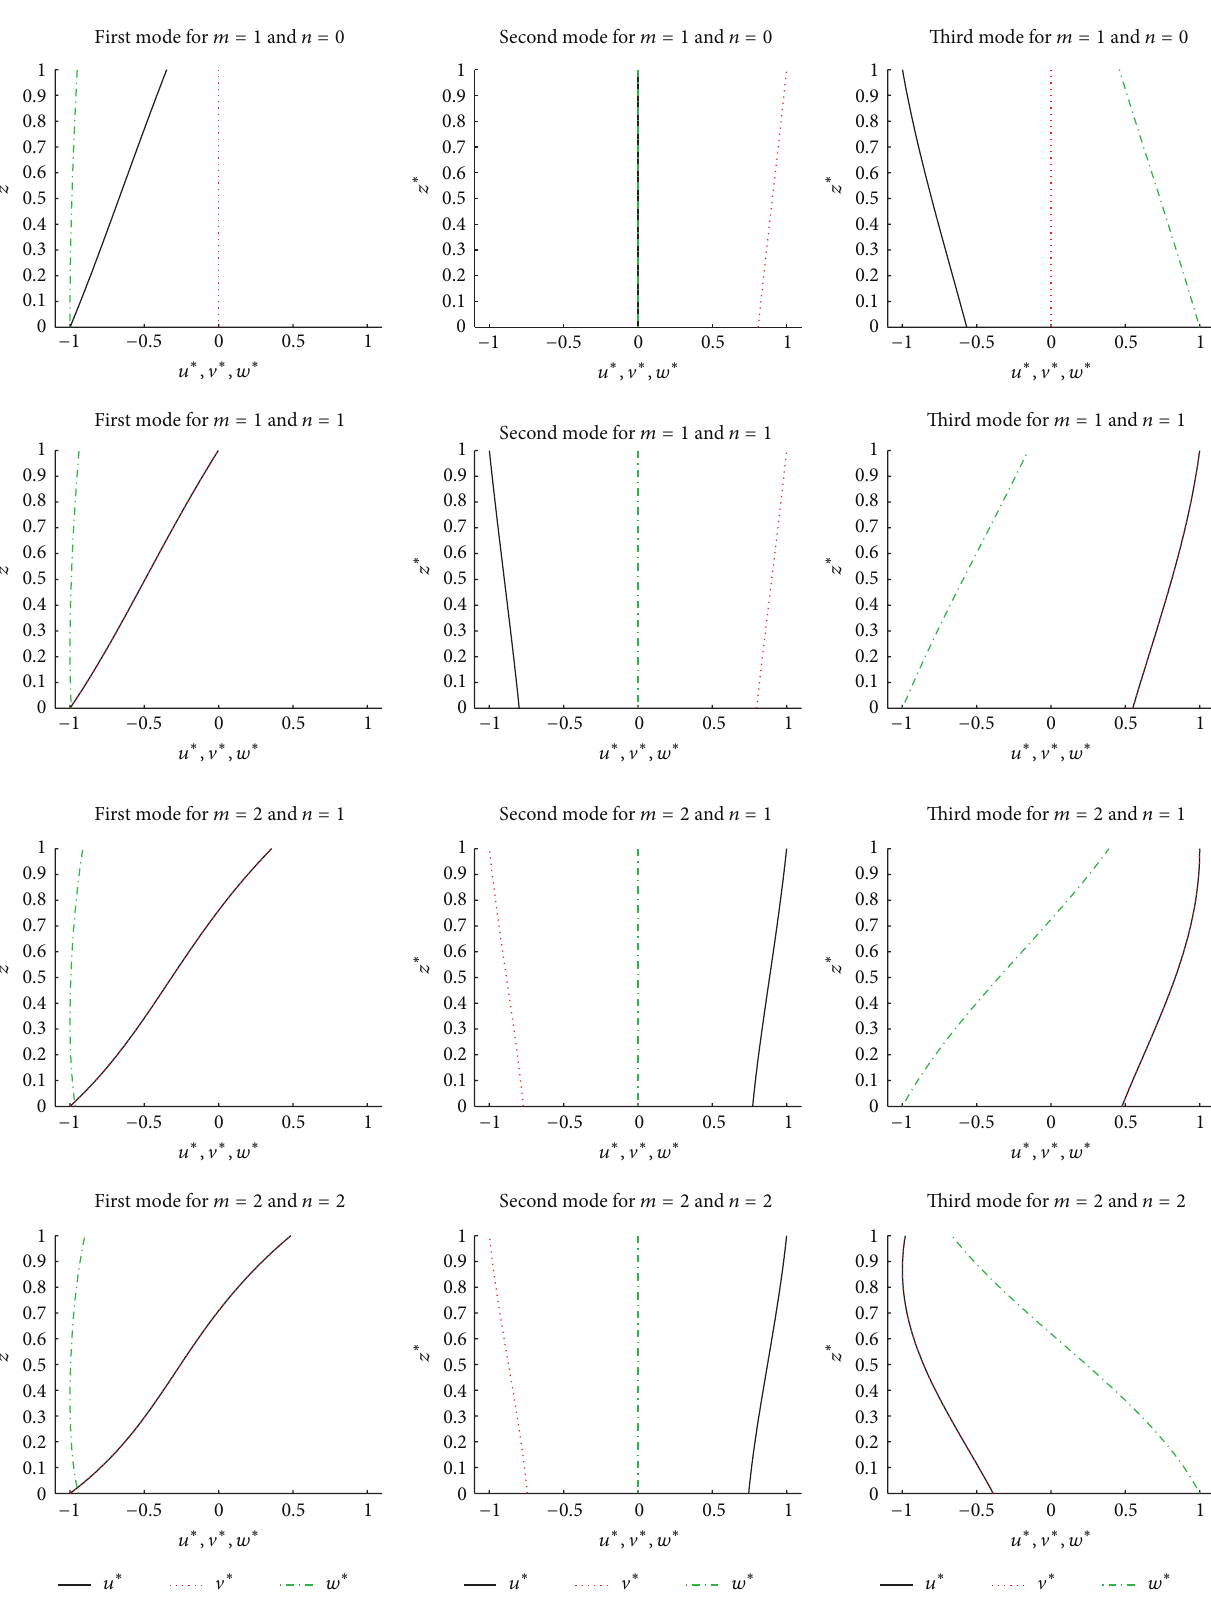
Figure 10: Benchmark 9, simply supported isotropic spherical shell panel. First three vibration modes in terms of displacement components through the thickness for thickness ratio 𝑅 𝛼 /ℎ = 5 and several combinations of half-wave